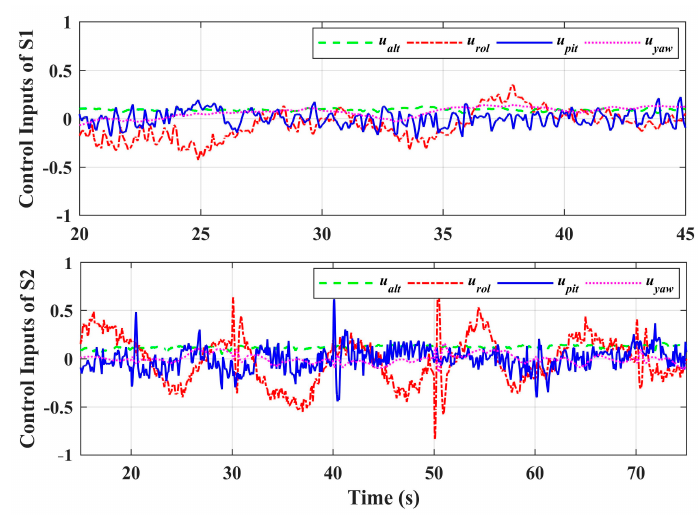
Figure 16. Control inputs of Scenario 1 and Scenario 2.